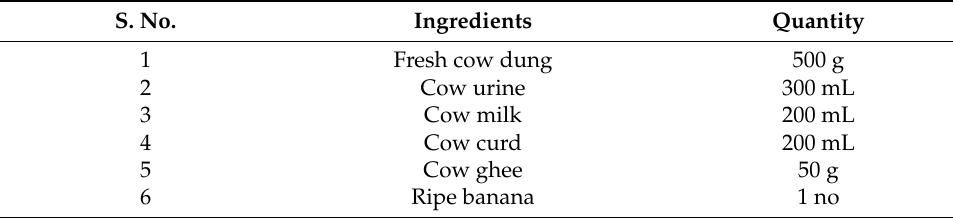
Table 2. Scaled-down ingredients.